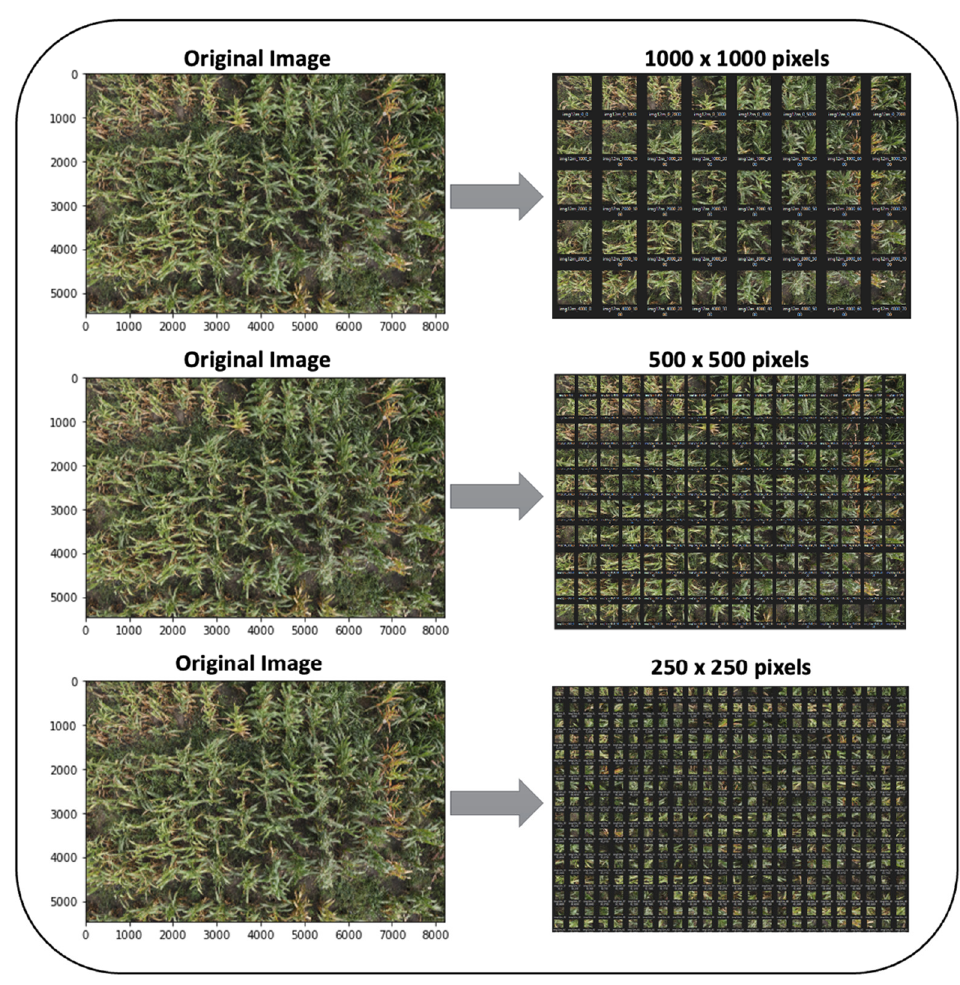
Figure 2. Overall Tile Dataset Generation Workflow. Table 1. Dataset distribution for training deep learning models for identifying diseased regions us ‐ ing tile segmentation.